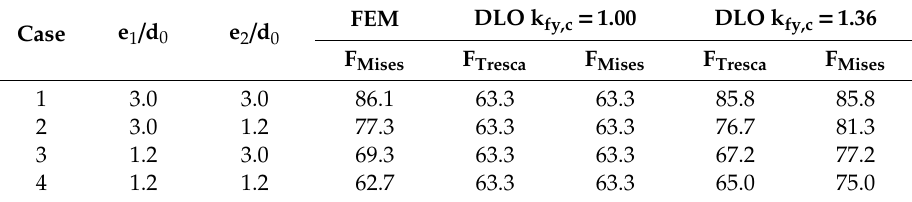
Table 3. Overview, dimensions, and ultimate loads in kN for the considered cases.